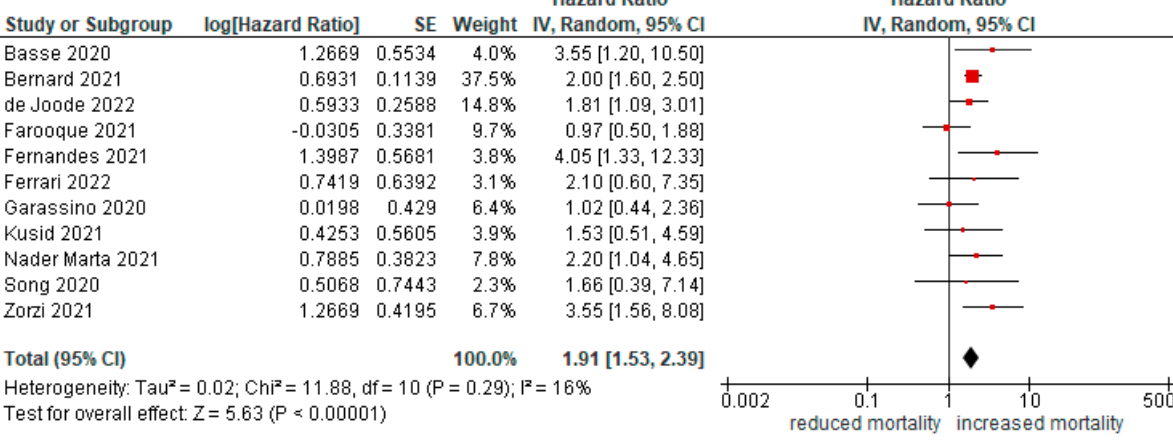
Figure 5. Forest plot for risk of mortality in lung cancer compared with other malignancies.